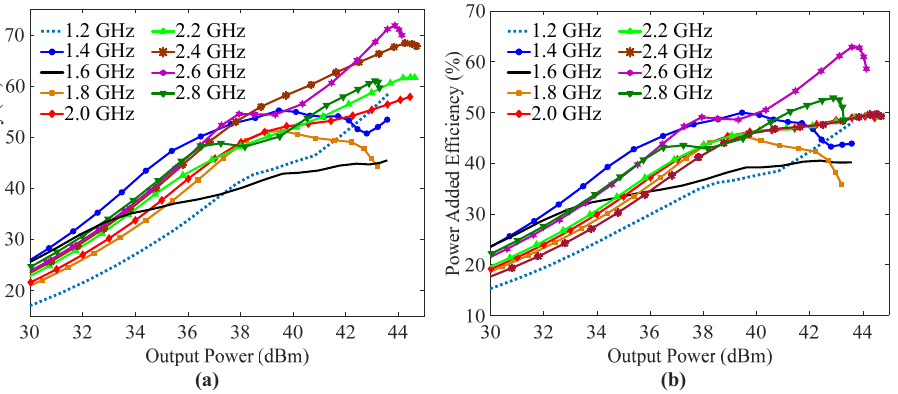
Figure 12. Measured ( a ) drain efficiencies and ( b ) gains of the fabricated DPA versus output power at different frequencies.